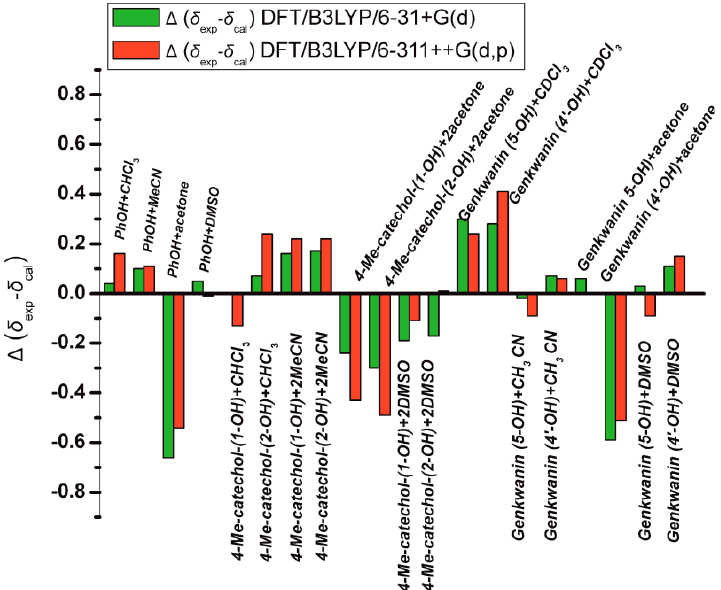
Figure 18. Histogram of the errors Δ( δ DFT/B3LYP/6-311++ G(2d,p) level of theory) 1 H OH chemical shifts with minimization of the solvation complexes at the DFT/B3LYP/6-31+G(d) and DFT/B3LYP/6-311++G(d,p) level of theory. Reprinted with permission from [41]. Copyright 2013, The Royal Society of